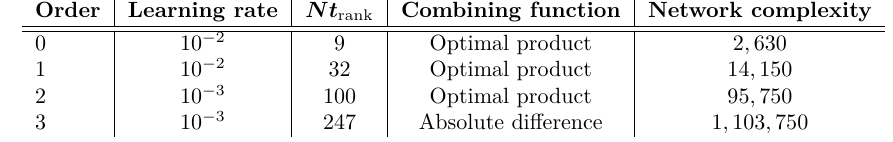
Table 2: Impact of boolean masking implementations on the conditional variational autoencoder performance (with batch-size = 64, N v =